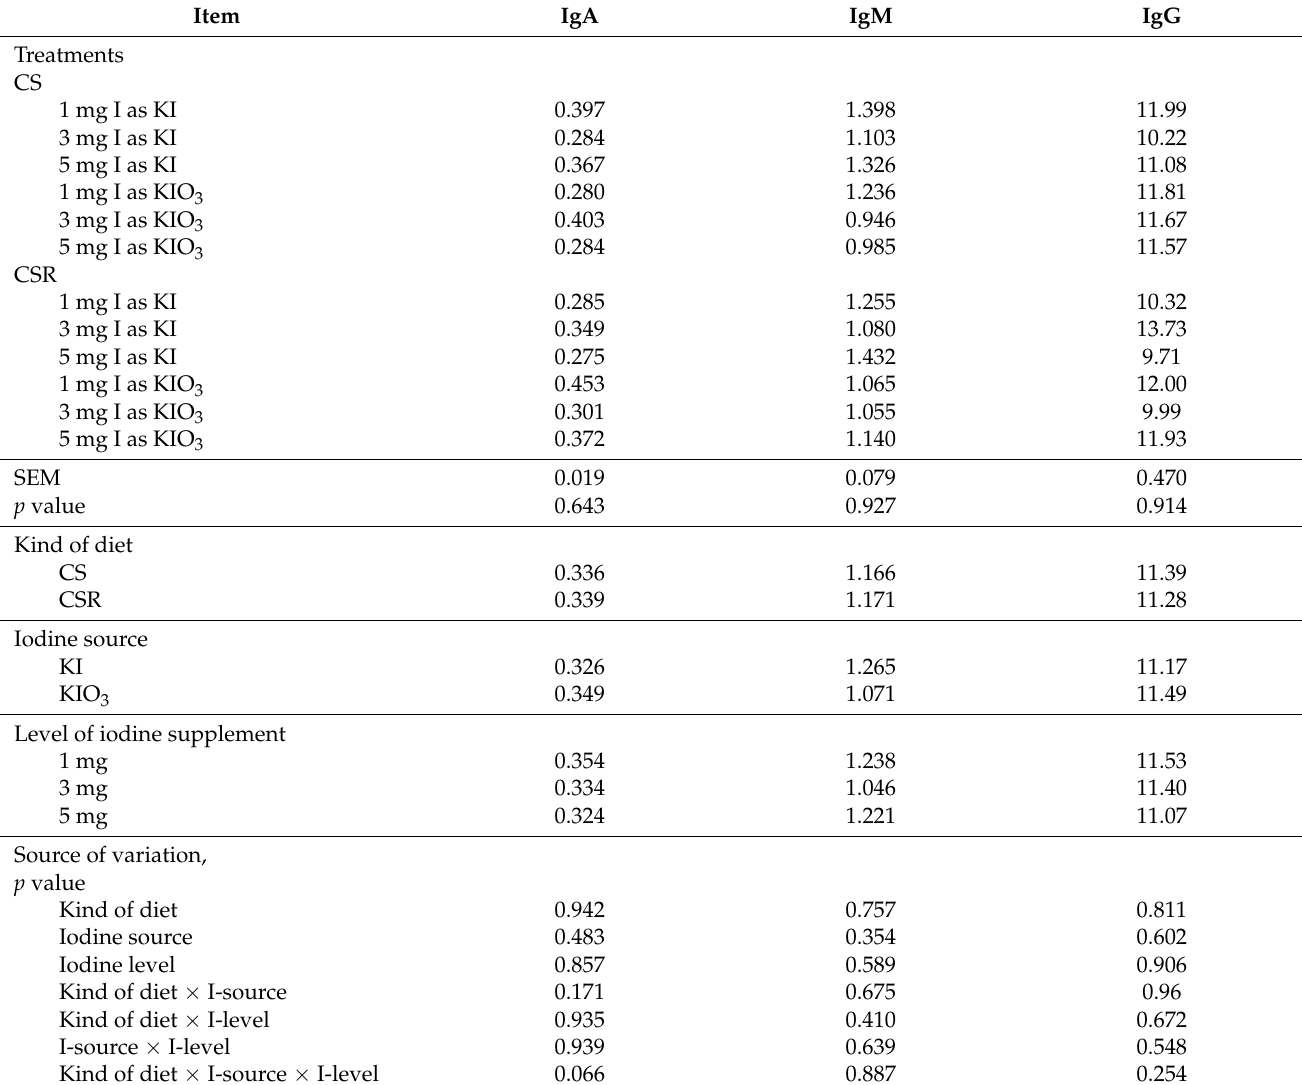
Table 5. Immunoglobulin concentration in hen blood serum (g/L) (Exp.